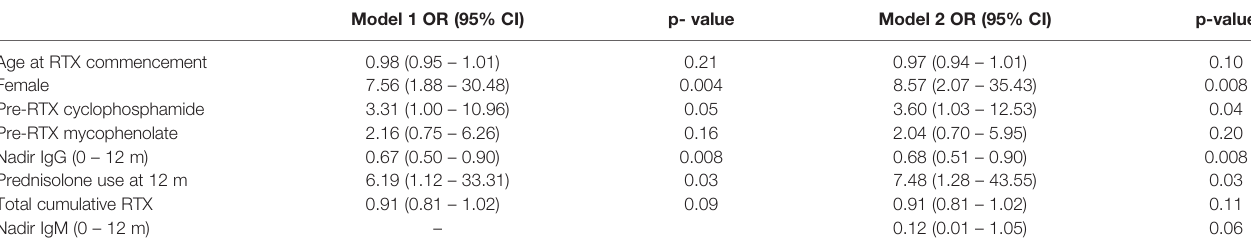
TABLE 3 | IgG < 5 g/L or immunoglobulin replacement at 60